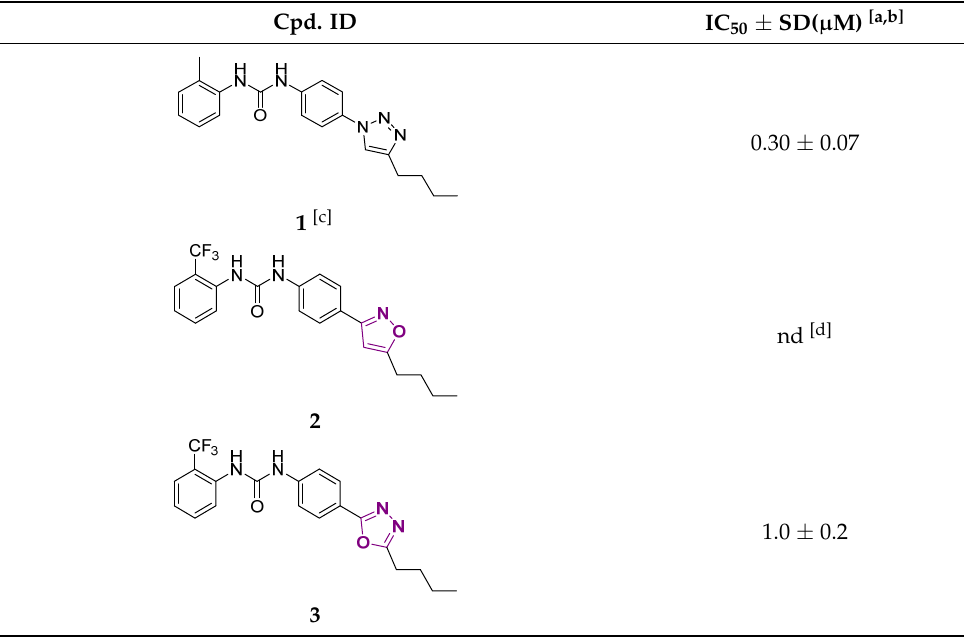
Figure 4. Two-dimensional (2D) structures of the hit compound already published (compound 1) and of the novel compounds selected through our computational model. * Hit compound previ- ously published. Table 1. DDX3X anti-enzymatic activity.